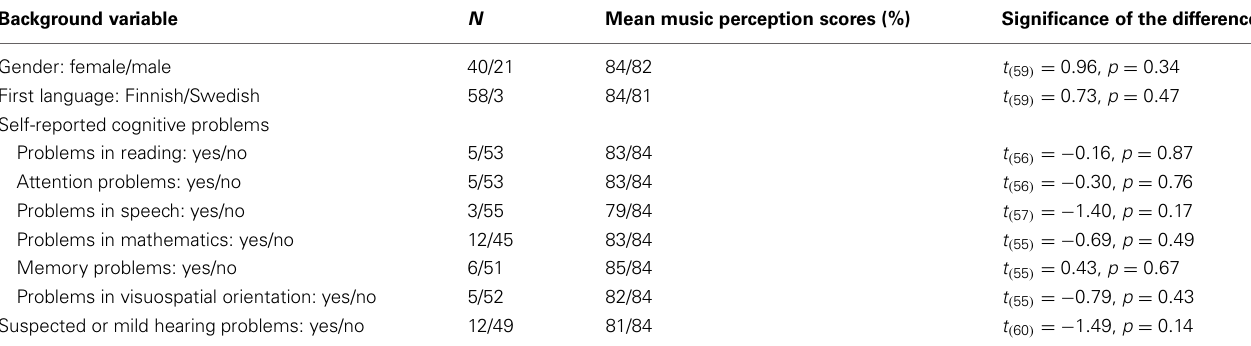
Table 5 | Background variables’ associations with the music perception total score.